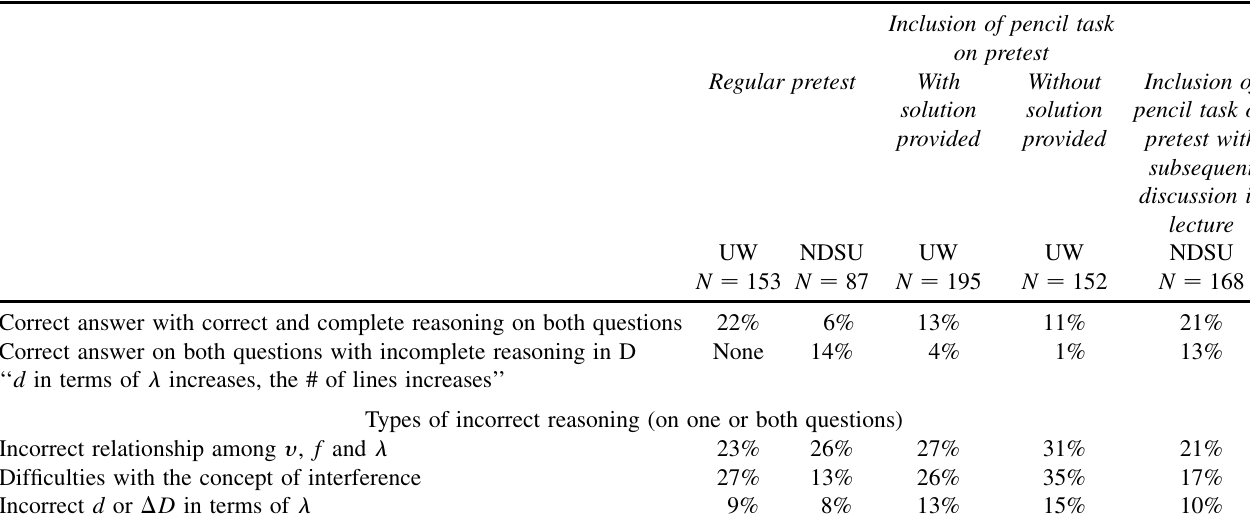
TABLE VIII. Summary of results for parts D and E of the two-source interference problem after all instruction, and either with or without various prompts intended to help students use skills they had demonstrated in the context of concrete, everyday objects to the context of water